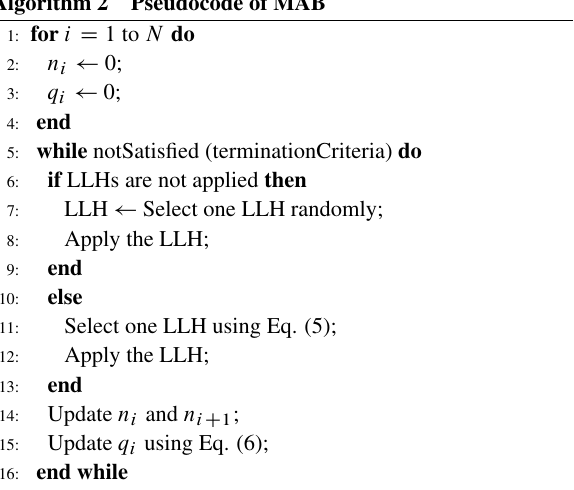
Algorithm 2 Pseudocode of MAB